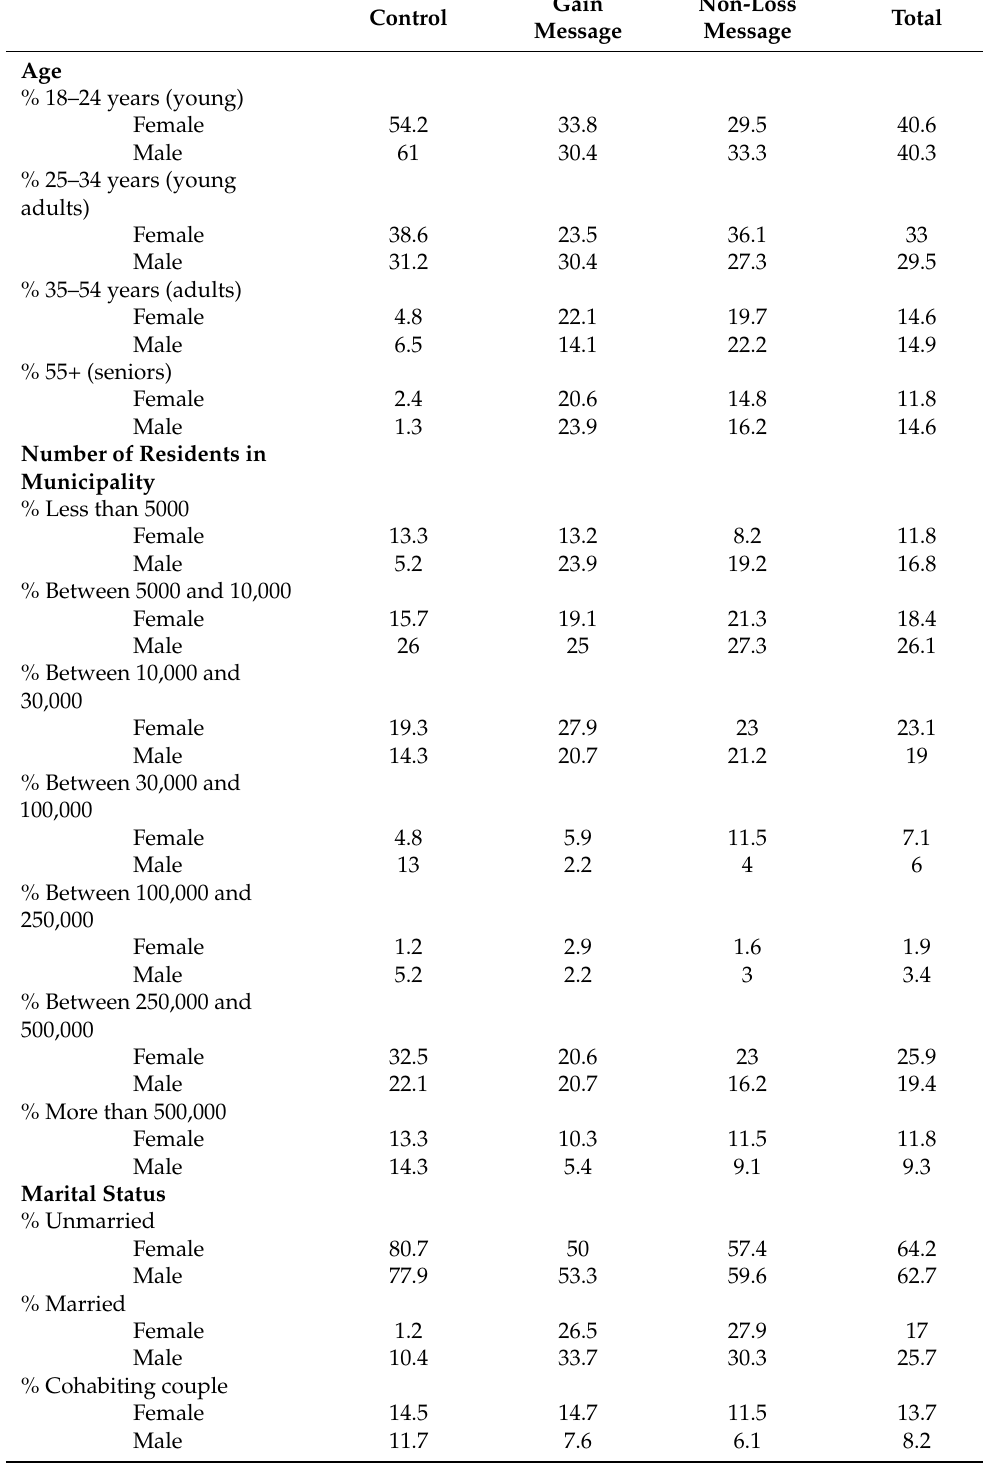
Table 1. Demographics of study